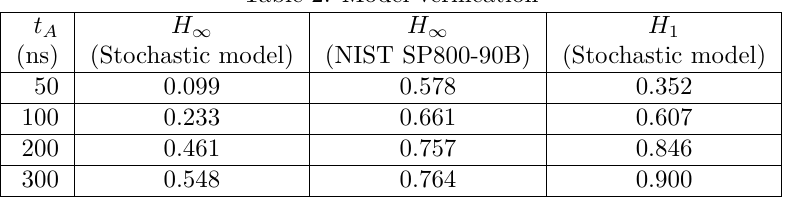
Figure 10: FPGA implementation of the digital noise source. Table 2: Model